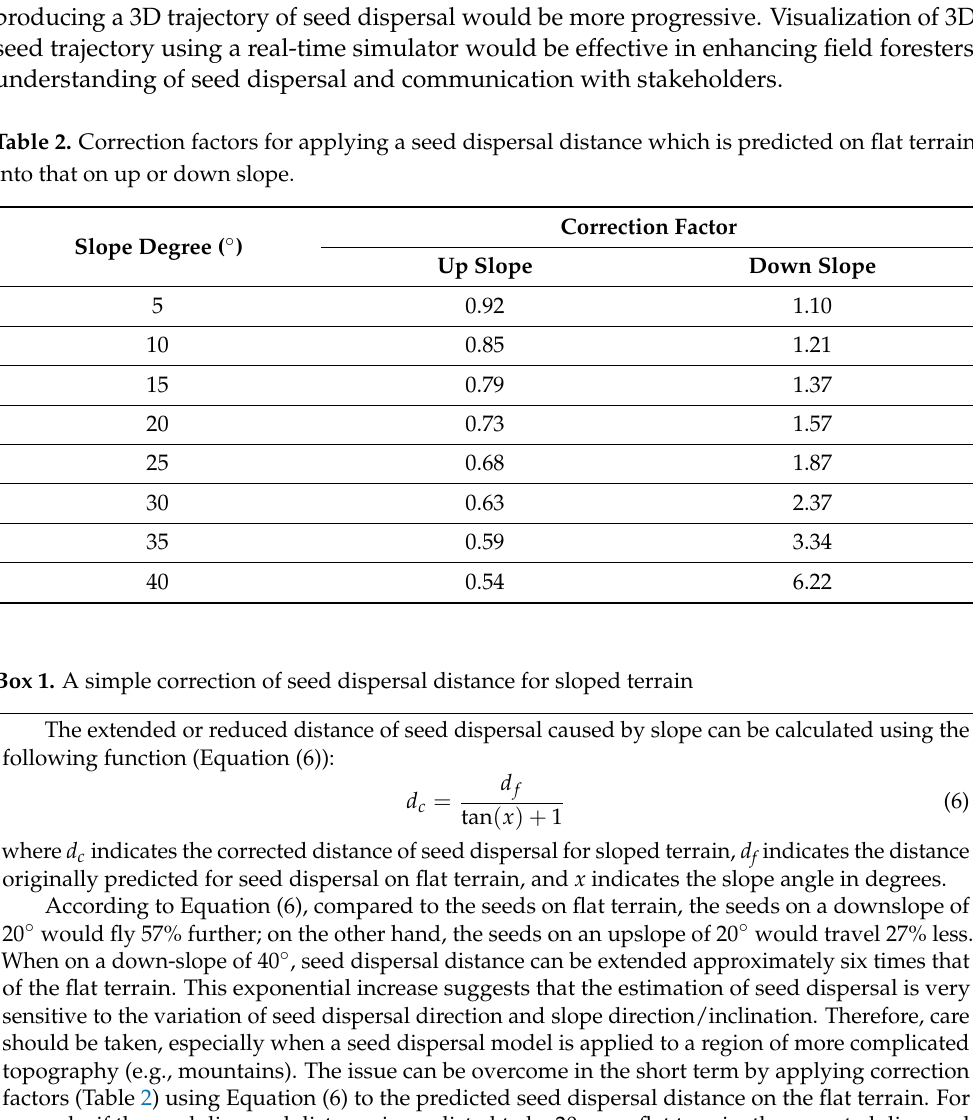
Correction Factor Up Slope Down Slope